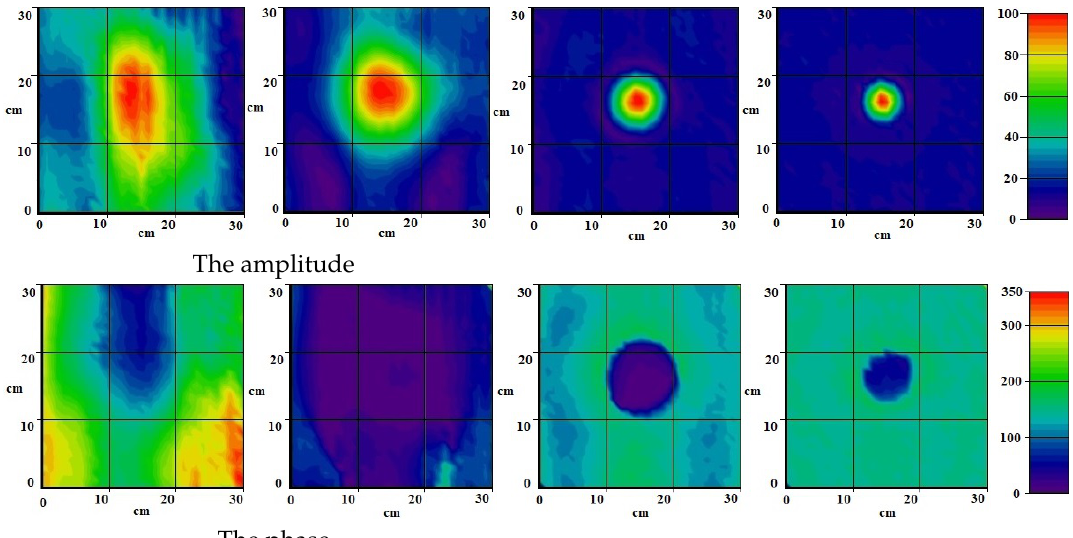
Figure 9. Measured amplitude and phase at the installation surface. At frequencies 2.5, 3, 6, and 12